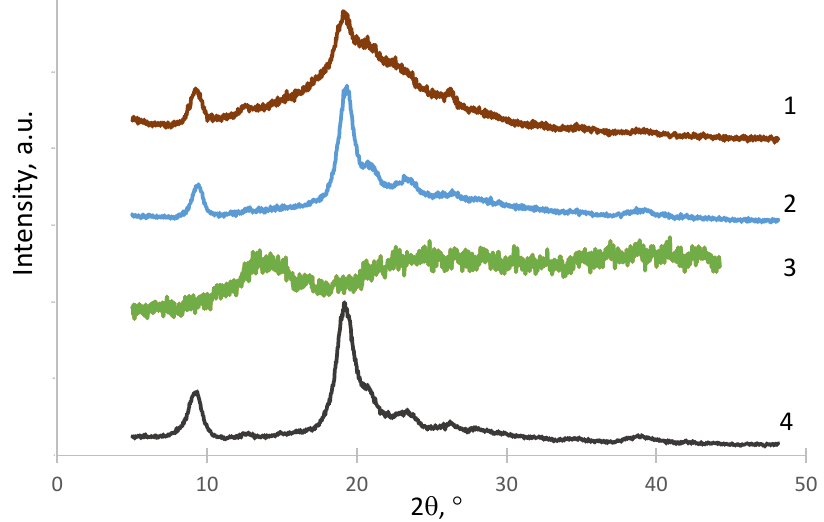
Figure 2. X-ray diffractograms of CNW – ALG 1 (1), CNW – ALG 1w (2), ALG (3), and CNWs (4).